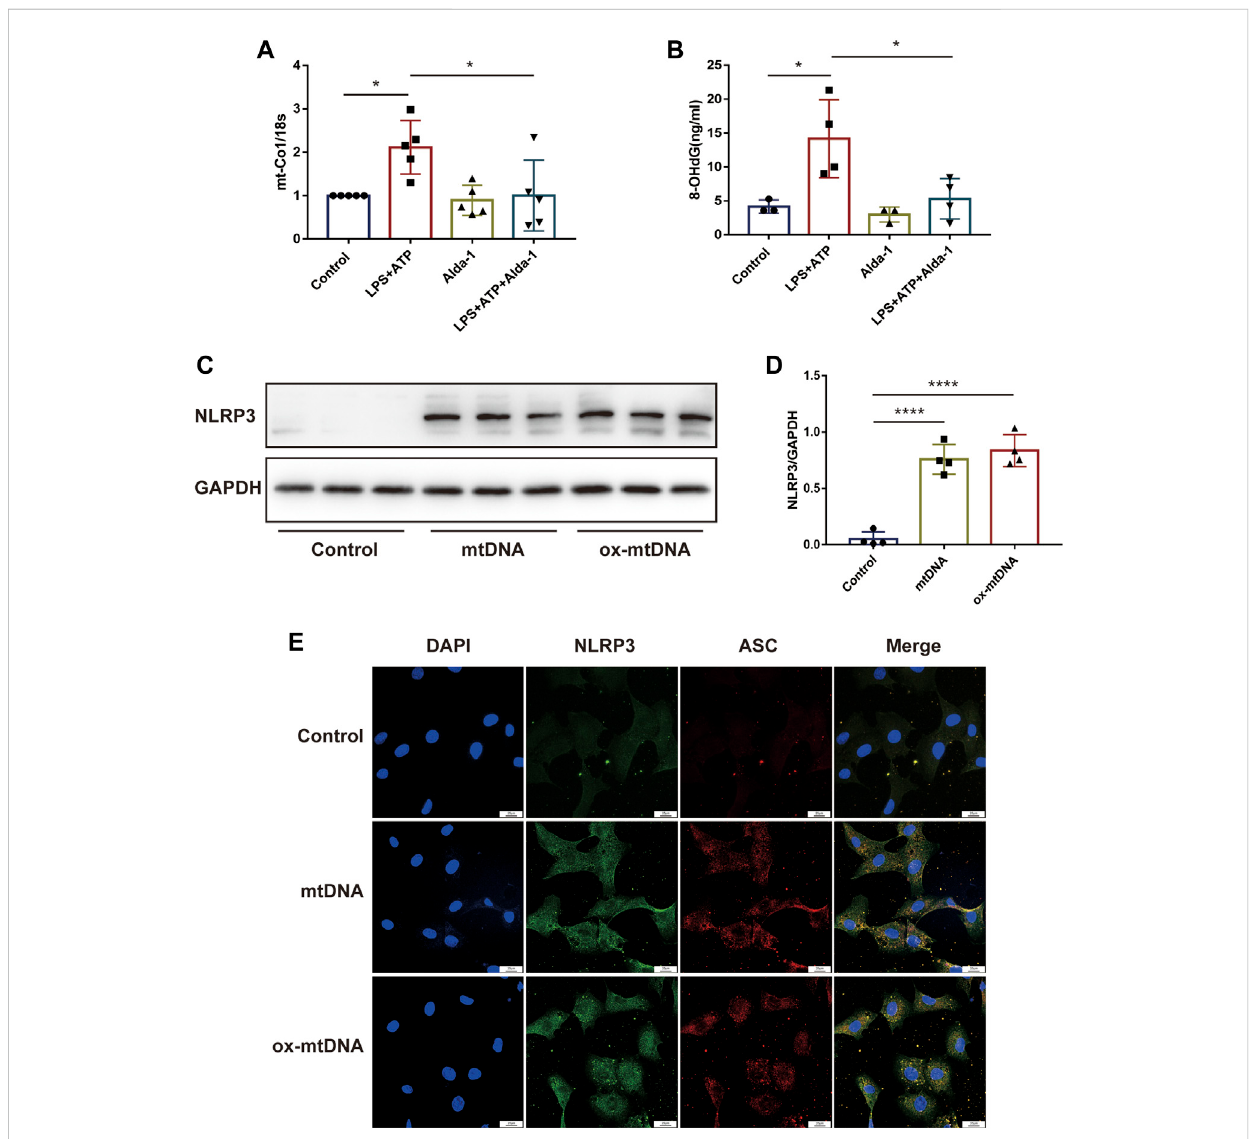
FIGURE 4 MtDNA and ox-mtDNA promotes NLRP3 expression and NLRP3 in fl ammasome activation. (A,B) The levels of total mtDNA or 8-OHdG (ox-mtDNA) in LPS plus ATP-stimulated or control H9C2 cells pre-incubated with or without Alda-1, n = 3-5 per group. (C,D) Representative immunoblots and